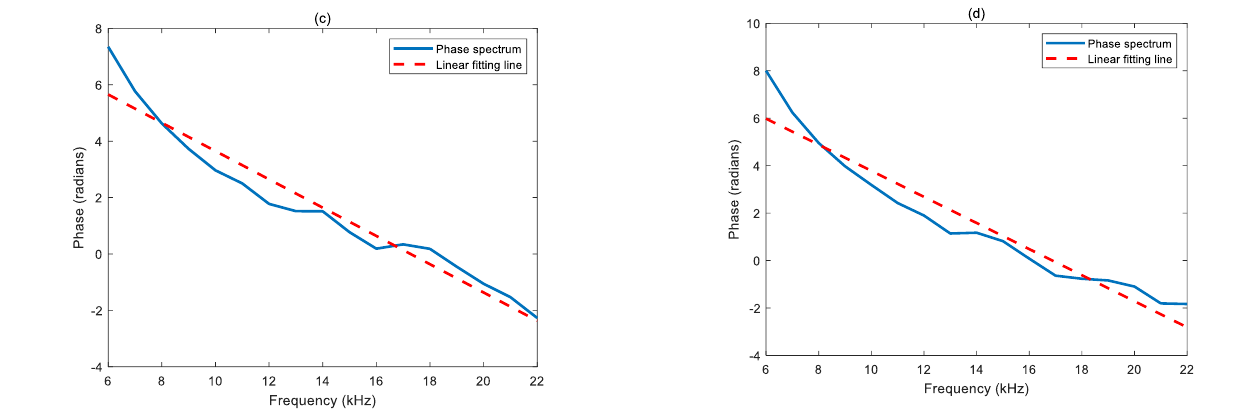
Figure 1. The calculated phase-versus-frequency curves (blue) and the corresponding linear fitting lines (red dotted). ( a – d ) correspond to four paths from lightning source to the stations. Table 2. Intermediate and final calculation results of different methods of group velocity